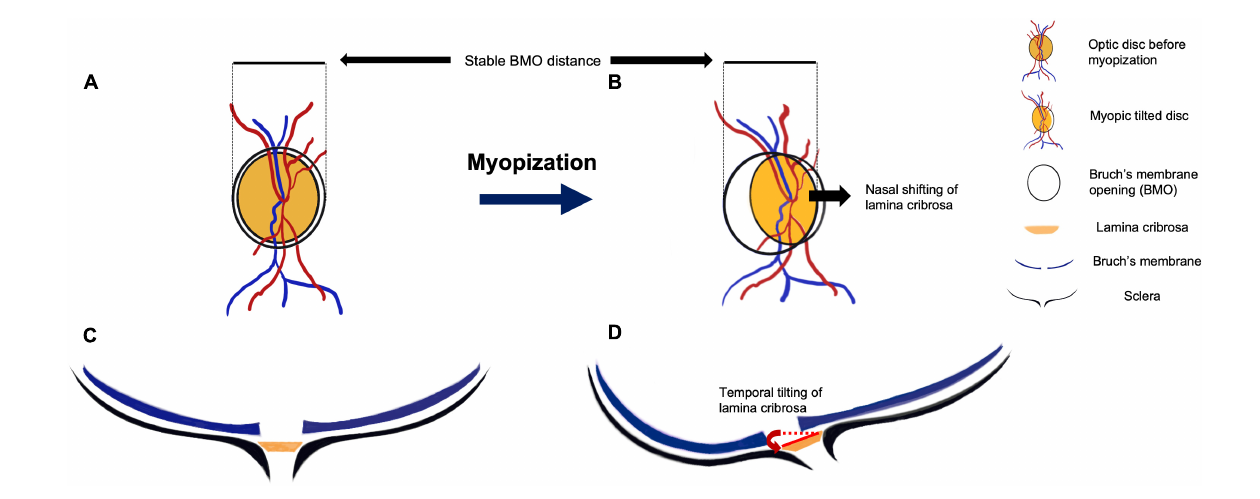
FIGURE4 The anatomic change during myopic tilted disc development. Panels (A,C) show the initial optic disc on fundus photograph and optical coherence tomography (OCT) horizontal scan, respectively. The black circle outside the optic disc indicates the Bruch’s membrane opening (BMO) windows (A,C) . The blue lines in Panels (C,D) indicate Bruch’s membrane (BM) layer, the black lines indicate the sclera of the eyeball, and the orange planes in between them represent the lamina cribrosa (LC). Panels (B,D) show the anatomic change after myopic progression. After the posterior scleral deformation, the tensile strength of the sclera is conducted to the LC. The LC is dragged nasally under the BMO window, along with the blood vessels that pass through the LC (B) . This nasal shifting and tilting of LC lead to misalignment of BM and formation of peripapillary atrophy. During the optic disc tilting, the distance between BMO remains relatively unchanged (B,D) . In the cross-sectional view (D) , the posterior protrusion of the sclera stretches the LC toward the deepest point of eyeball, resulting in a more oval disc and disc torsion appearance on the fundus photograph (B)